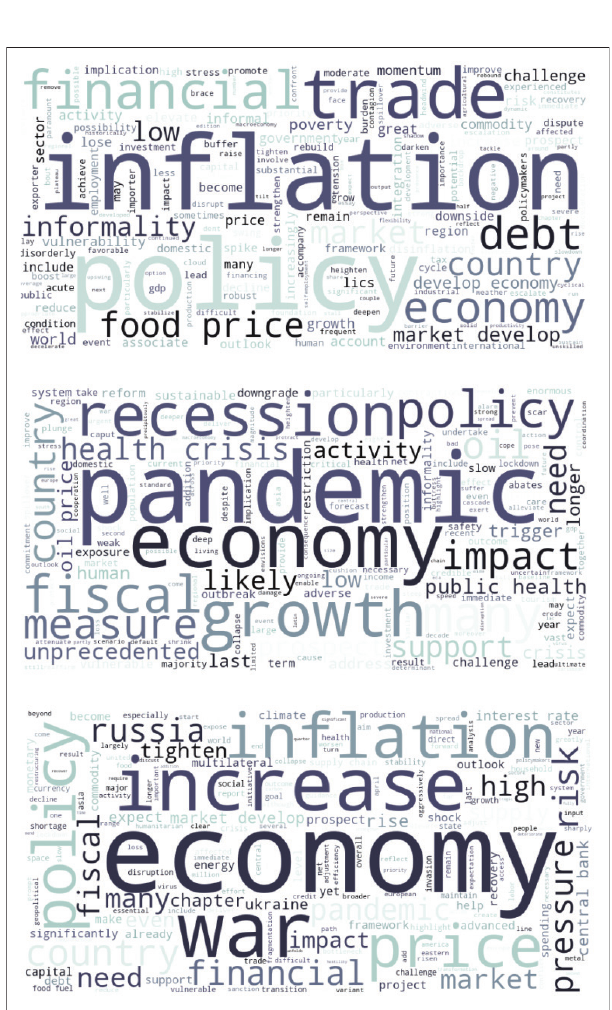
FIGURE 1: The word clouds indicate how the global economic outlook changed from 2019 to 2022; the top two summarise the World Bank global outlook published in 2019 and 2020, respectively, and the bottom one summarises the International Monetary Fund global economic outlook published in April 2022.